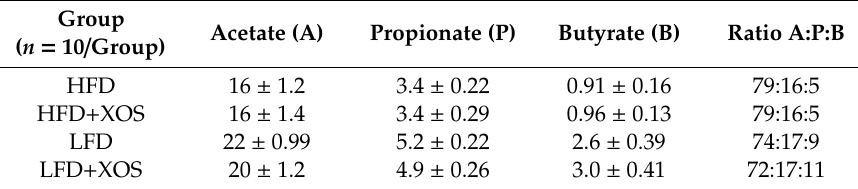
Table 1. The concentrations of SCFA (mM, mean ± SEM) and acetate (A): propionate (P): butyrate (B) ratio in the cecum of the